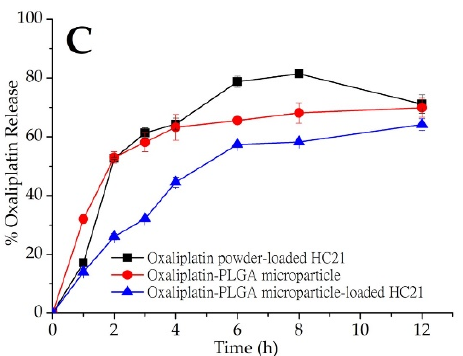
Figure 3. In vitro oxaliplatin release from PLGA microparticles (red, ● ). Oxaliplatin release profile from oxaliplatin powder and oxaliplatin-PLGA microparticles-loaded in ( A ) HC12; ( B ) Guardix-Sol ® ; and ( C ) HC21 hydrogel. Mean ± S.D. (n = 3).